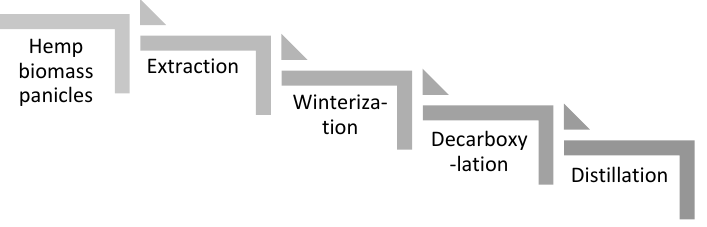
Figure 5. Scheme of hemp biomass conversion into high purity distillate.